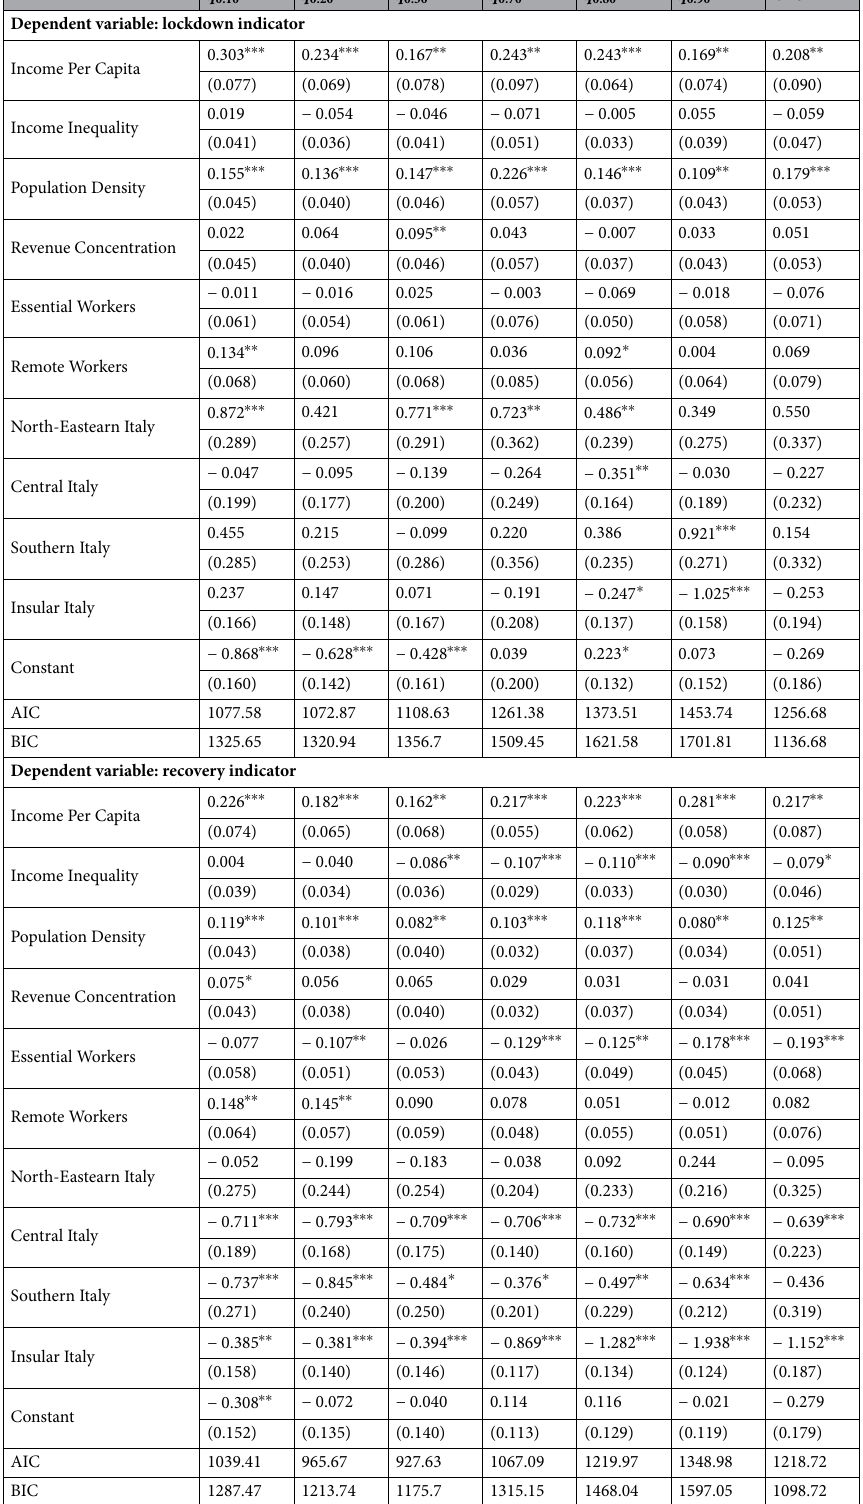
Table 1. Results for quantile regression of the lockdown (top) and recovery (bottom) indicators with respect to economic, sectorial and geographic explanatory variables, including interaction of macroareas with sectorial variables. Regression obtained with the Iterative Weighted Least Squares method on standardized variables. Last column shows OLS regression as a reference. Number of observations: 495. Coefficients shown for a subset of variables, full regression table reported in Tables S8 and S9 in the SI. Results with heteroskedastic- robust standard errors, obtained via wild bootstrap (1000 replications) reported in Tables S10 and S11 in